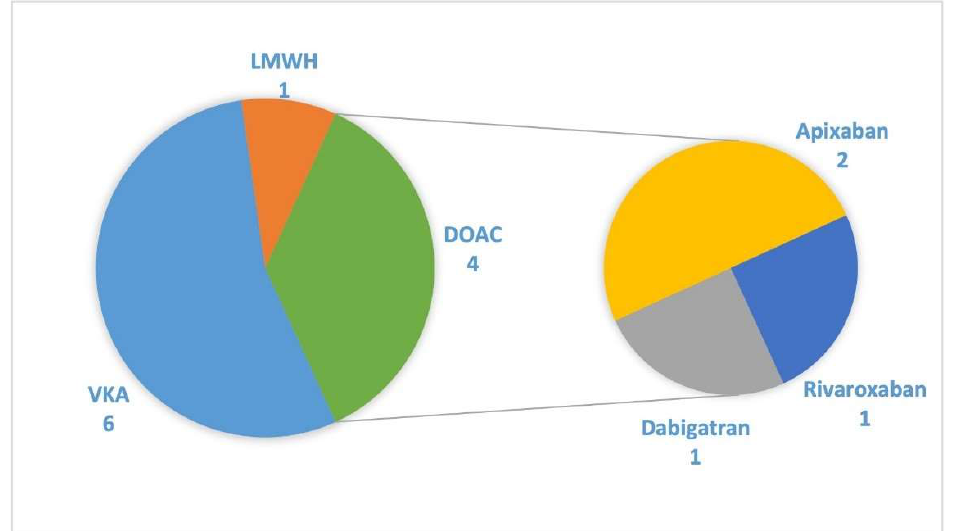
Figure 4. Type of anticoagulant therapy before admission in patients with domiciliary anticoagulant treatment ( n = 11). VKA, vitamin K antagonists; LMWH; low-molecular-weight heparin; DOAC: direct oral anticoagulant (Apixaban 5 mg twice a day, Dabigatran 150 mg twice a day, and Rivaroxaban 20 mg once a day).